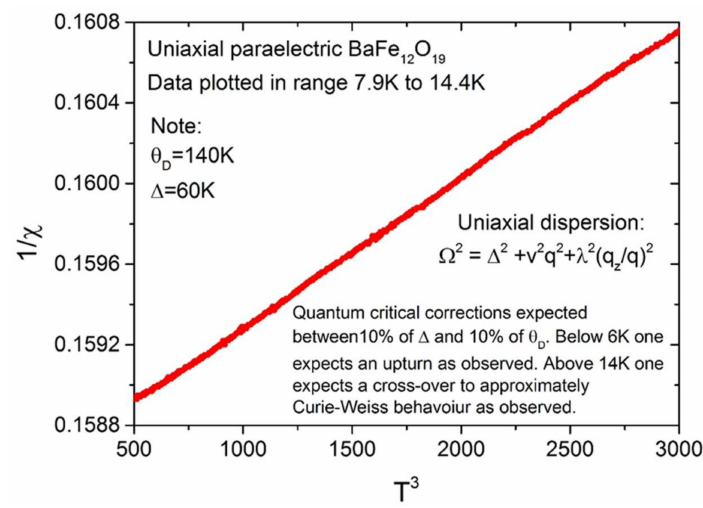
Figure 4. Dielectric constant T-cubed dependence in BaFe 12 O 19 .